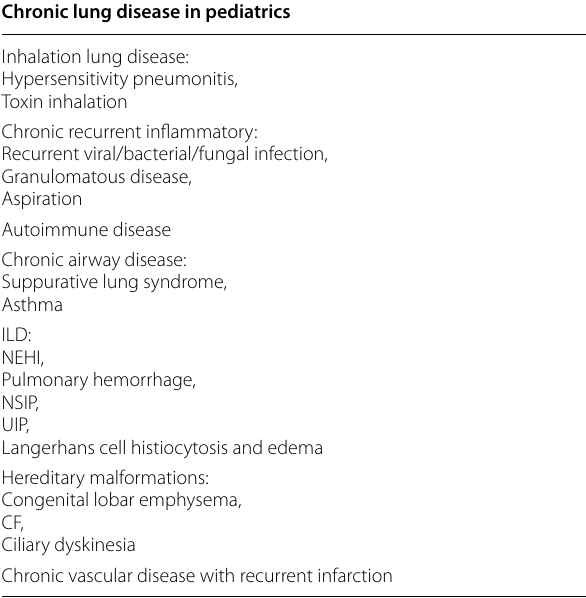
Table 2 Various etiological diagnoses of studied cases with pediatric chronic lung